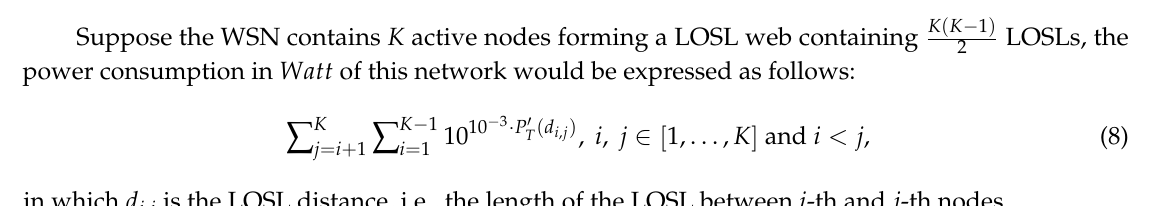
Figure 6. Required power for the transmitter to guarantee RFT detection in terms of the LOSL